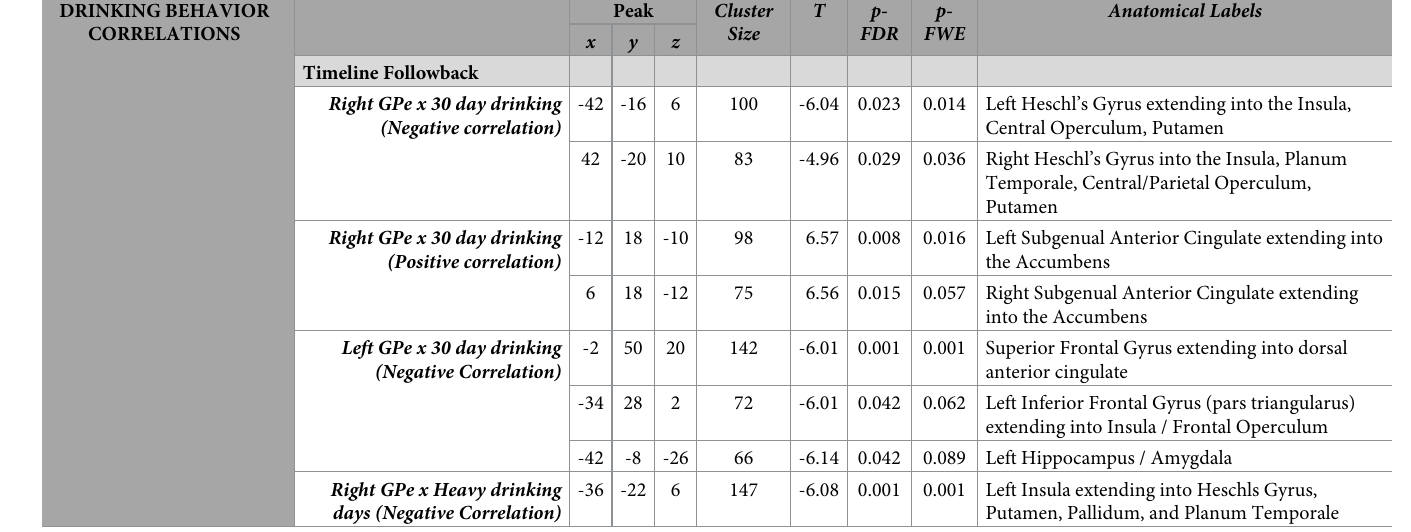
Table 3. Associations between alcohol induced changes in GPe connectivity and drinking behaviors. DRINKING BEHAVIOR CORRELATIONS